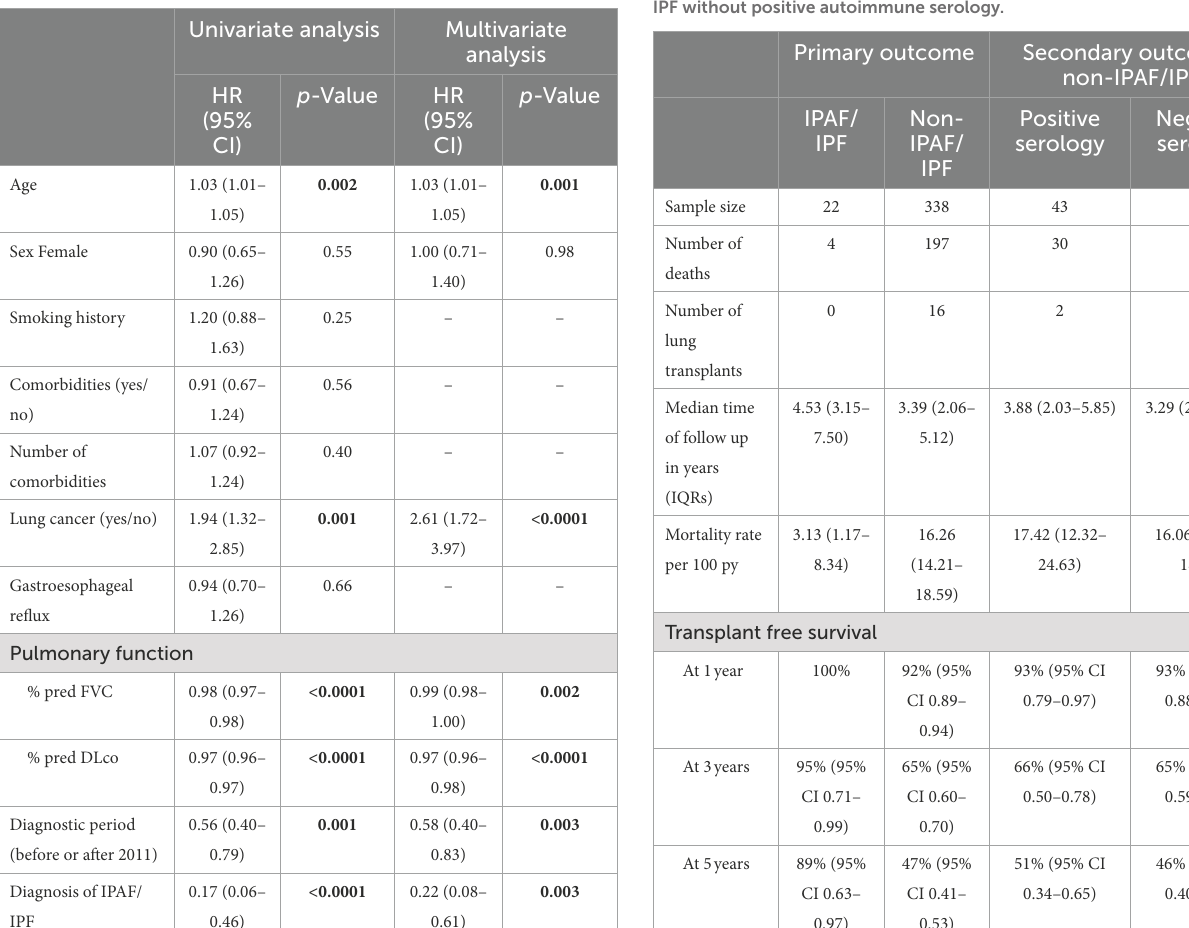
TABLE 4 Survival analysis for the primary outcome of the study: IPAF/IPF compared to non-IPAF/IPF and for the secondary outcome of the